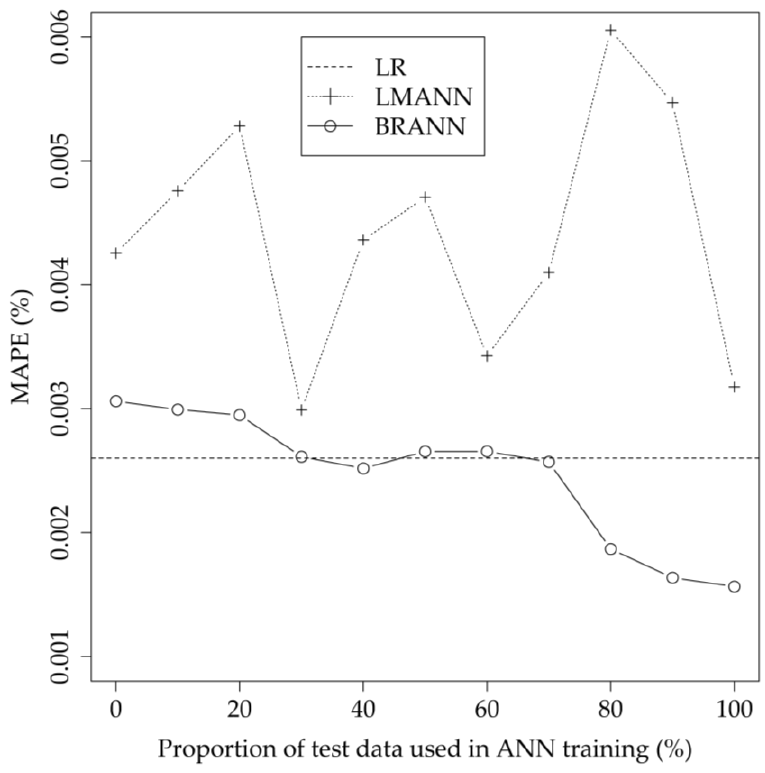
Figure 12. The dependence of MAPE (all data) on the used set of training data.